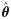
Verification of the FSP-FIM for models with non-Gaussian distributions.The inverse of the FIM is a lower bound on the variance of the MLE estimator. Here, we simulate 200 data sets with 1,000 cells in each data set. We then find the MLE θ^ (scatter plots) for each, and compare the covariance of these samples to the inverse of the FIM for the (a) FSP-, (b) LNA-, and (c) SM-FIM approaches. Panel (d) shows the FIM matrices for all approximations on the same axes. Simulated data were generated using the parameters given in the main text and at 10 time points evenly distributed between 0 and 200 minutes.